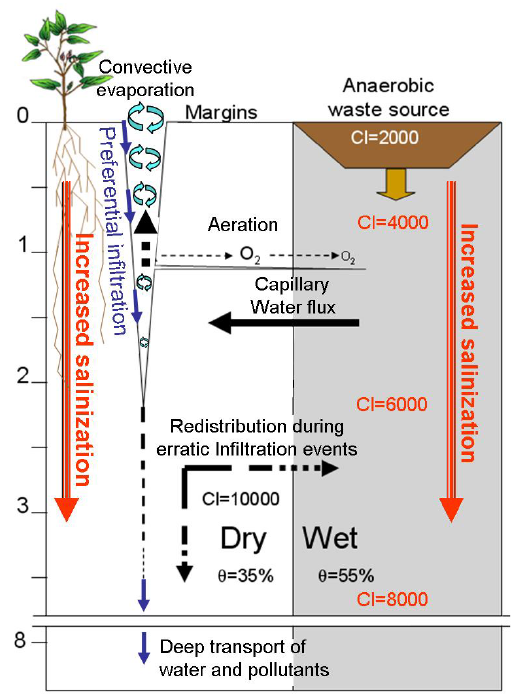
Fig. 8. Desiccation-crack-induced-salinization (DCIS) conceptual